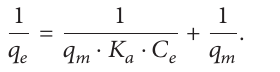
Figure 1: The linearized Langmuir adsorption isotherms of As (III) by the submerged